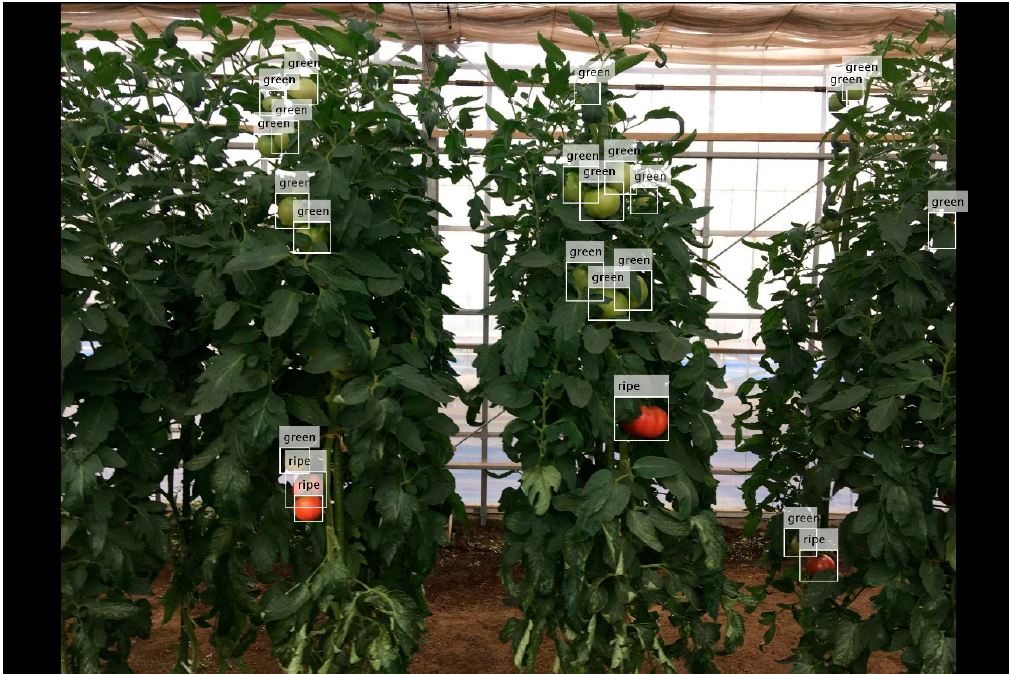
Figure13. Applicationoftomatodetectioninripenessestimation. Thetagslabelledripeorimmaturetomatoes. Figure 13. Application of tomato detection in ripeness estimation. The tags labelled ripe or immature tomatoes.